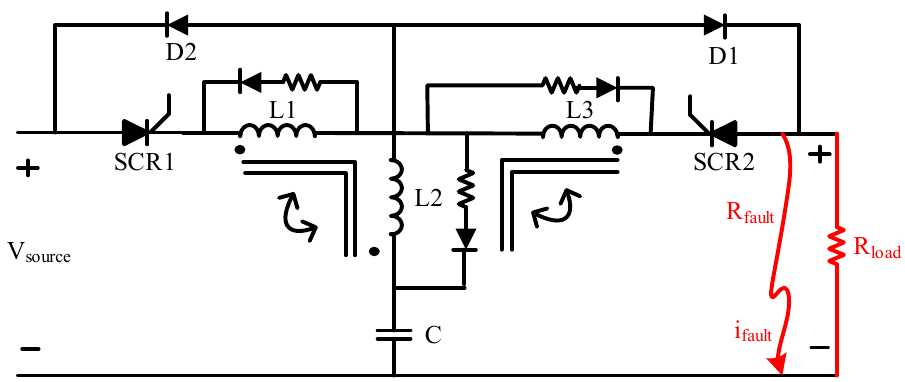
Figure 10. Novel bidirectional dc circuit breaker [35].